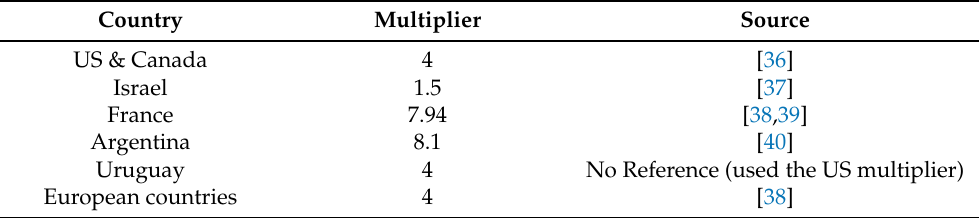
Table 2. Country Multipliers, m